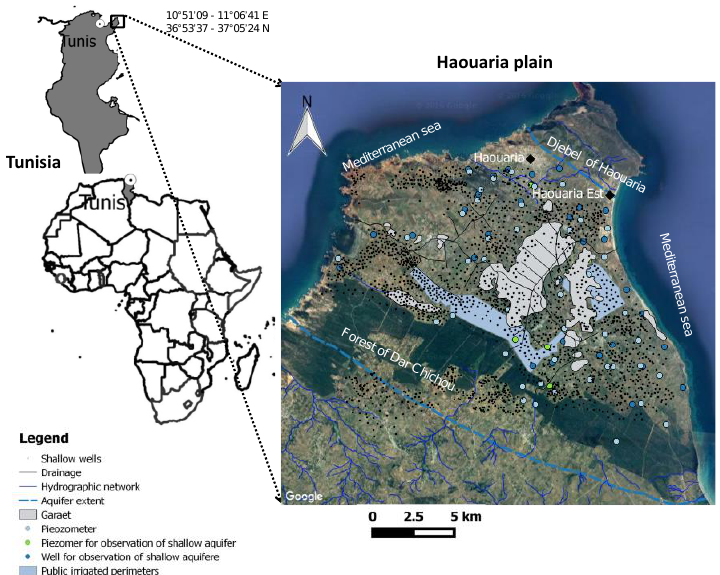
Figure 1. Localization and key characteristics of the study area. Garaet/Garâa is a natural wetland [25].